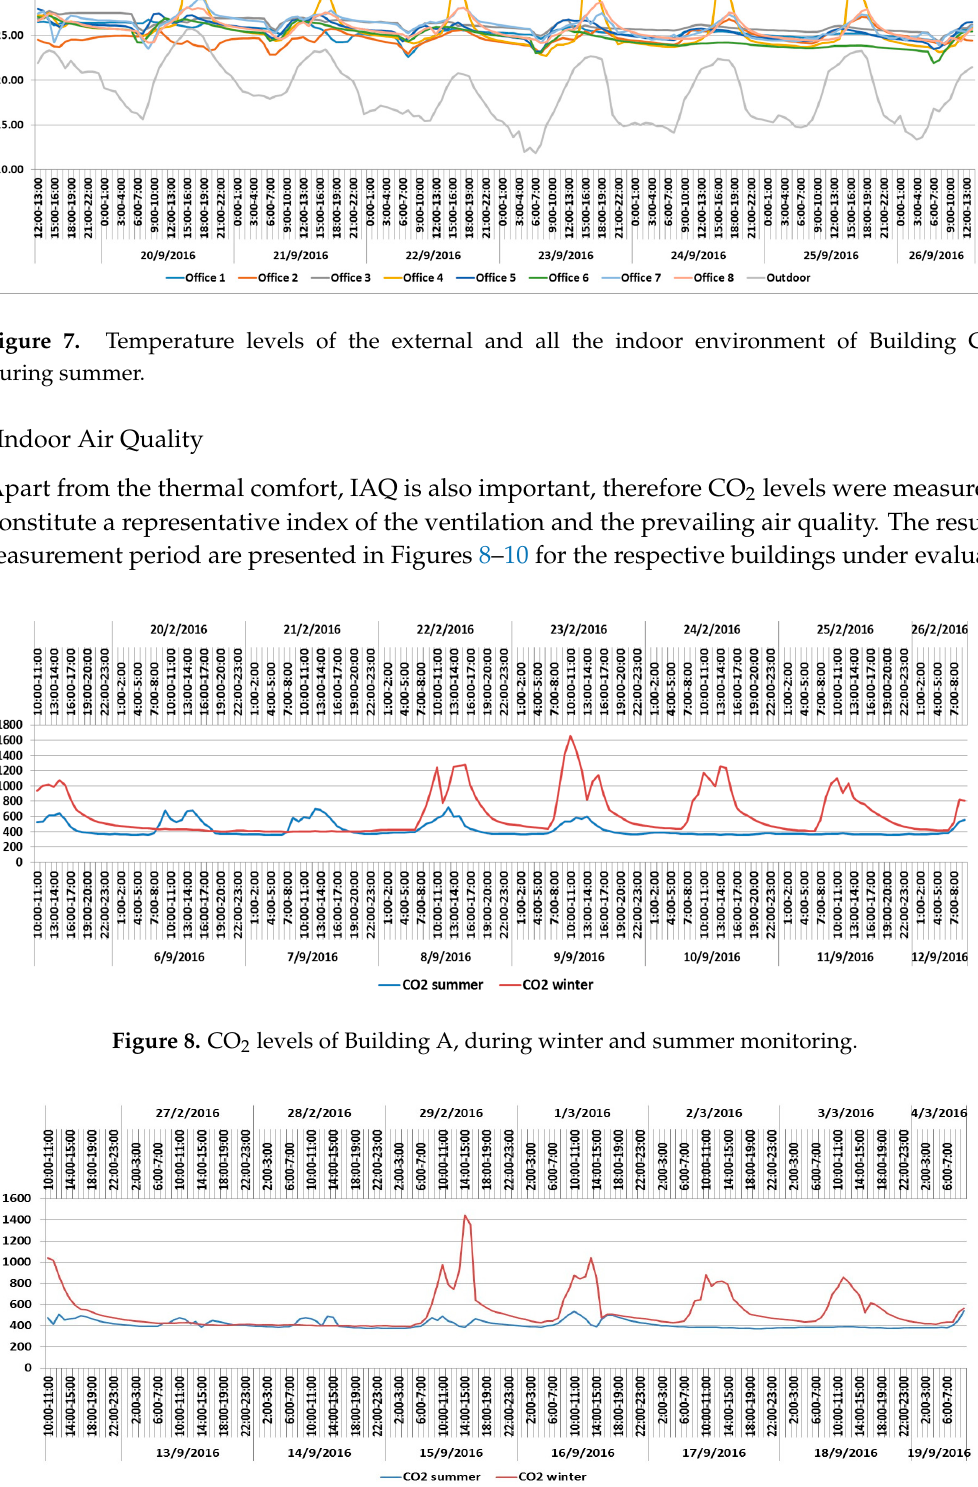
Figure 10. CO 2 levels of Building C, during winter and summer monitoring. The indoor CO 2 levels are evaluated based on the outdoor CO 2 concentration, in accordance with ASHRAE 62.1:2013. As outlined in Annexes B and C of the guideline, a stable concentration level of CO 2 at 700 ppm above the outdoor levels is recommended, as this ensures a comfortable and widely acceptable IAQ. The accepted levels of CO 2 concentration of the external environment vary from 300 to 500 ppm, therefore a maximum indoor concentration level of 1000 to 1200 ppm is recommended. Conditions where the levels of CO 2 exceed 5000 ppm can be characterized as extremely dangerous [42]. As deduced from the analysis, the CO 2 levels differ during the week. In the cases of Buildings A and B, which are naturally ventilated, the measured CO 2 levels during winter vary from 500 ppm in the morning to 1200 ppm at noon and reach for a short period of time even higher levels (Figures 8